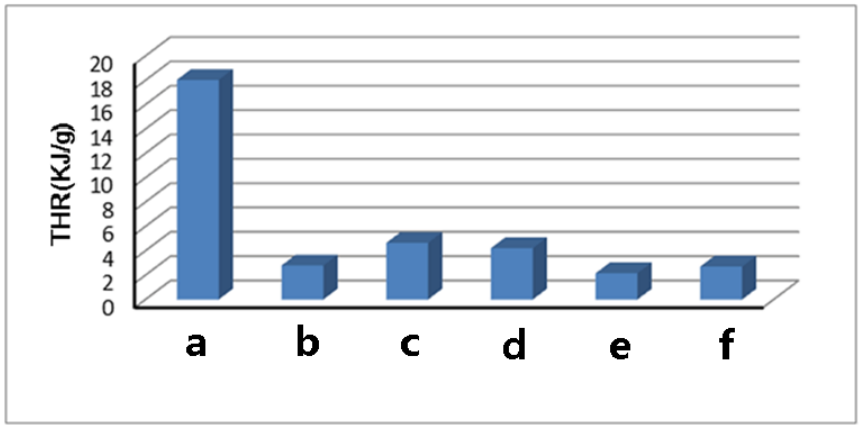
Figure 8. The total heart release (THR) of cellulose (a), cellulose-COOZn (b), cellulose-COOMg (c), cellulose-COOCa (d), cellulose-COONa (e), and cellulose-COOBa (f). Table 3. The result of LOI of cellulose and TOC.